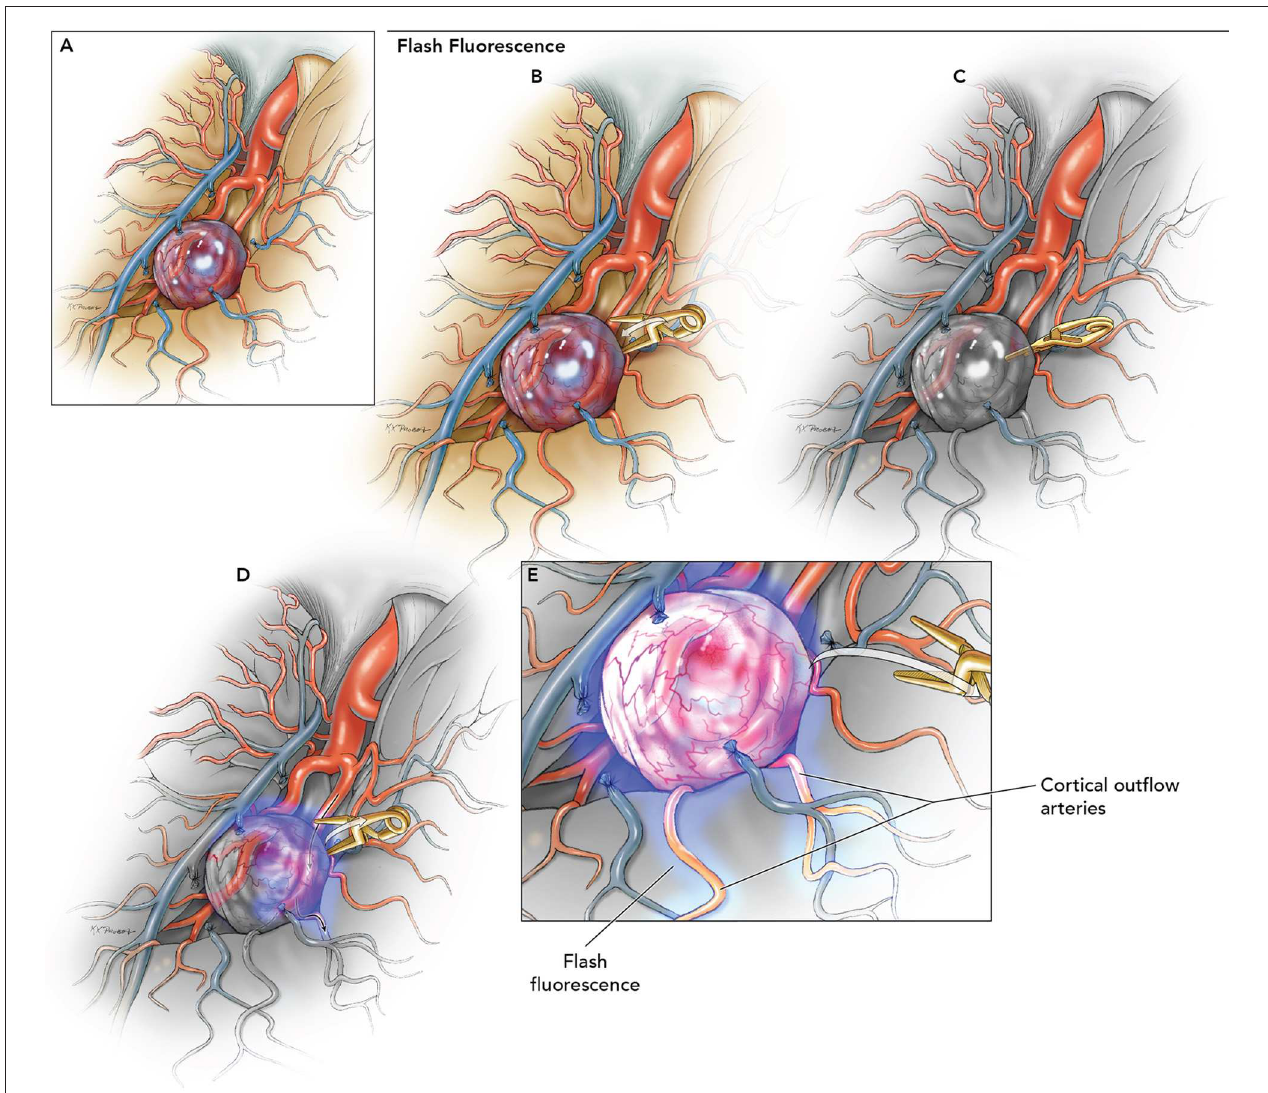
FIGURE 1 | Use of flash fluorescence technique to identify the efferent arteries of the aneurysm using ICG-VA. (A) Identification of candidate bypass recipient arteries among the surface M4 branches is difficult but could be improved using the following steps. (B) Temporary clip occlusion of the aneurysm inflow (afferent arteries) proximal to the aneurysm. (C) ICG-VA demonstrating initial fluorescence in uninvolved arterial branches. (D) Removal of temporary clip for aneurysm reperfusion. (E) Fluorescence seen in the efferent arteries to identify the most suitable recipient on the cortical surface for the bypass. Used with permission from Lawton